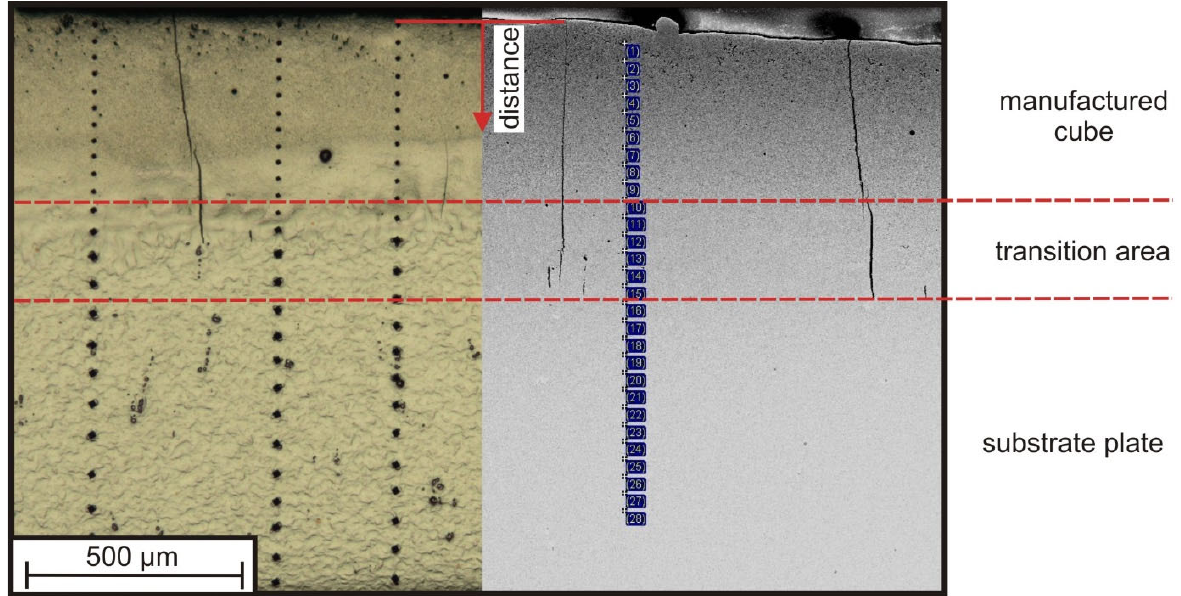
Figure 13. Exemplary hardness imprints ( left ) and measurement points of the EDS ‐ line scan ( right ). The measurement series started close to the top surface of the samples and continued along a straight line parallel to the PBF ‐ LB built direction (z ‐ axis) to the substrate plate.